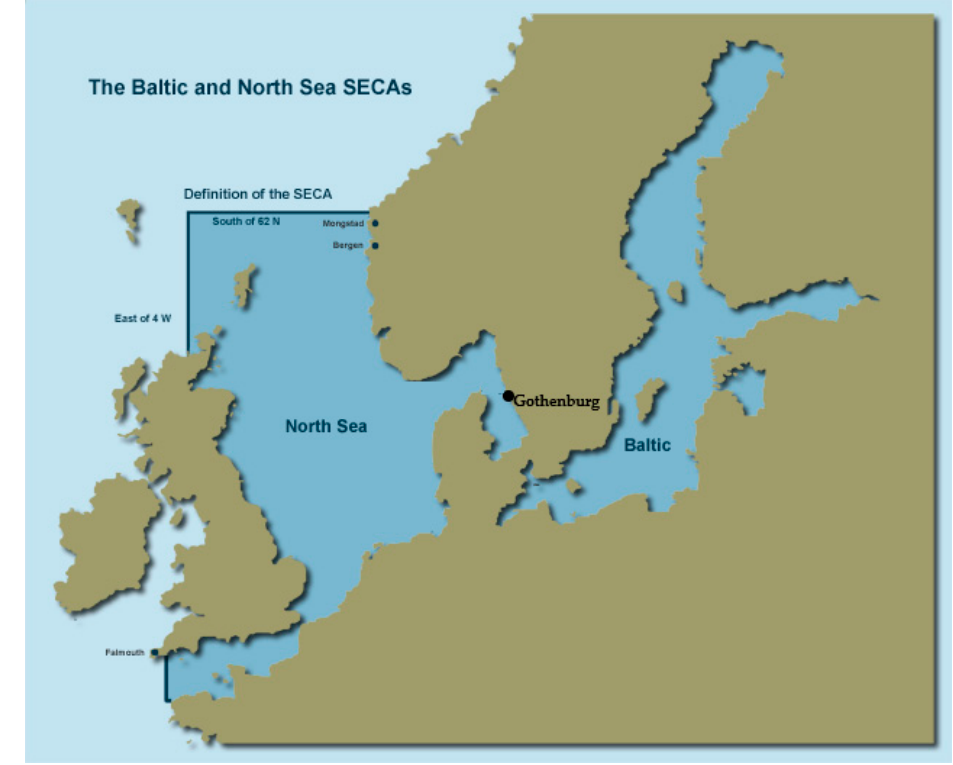
Figure 1. Sulfur emission control areas of the North and Baltic Seas.